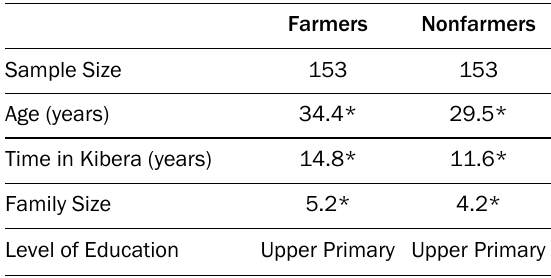
Table 1. Demographic Overview of the